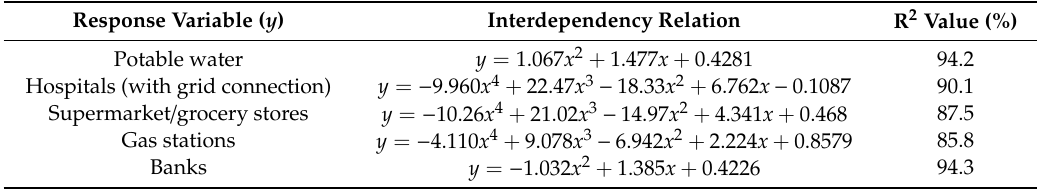
Table 2. Important non-linear recovery relations between power system (response variable, x ) and other critical infrastructure systems (response variables, y ), for post-disaster recovery